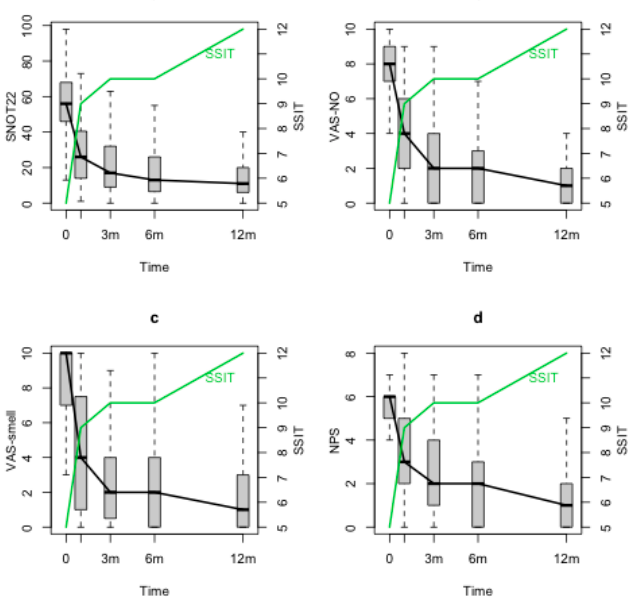
Figure 2. SSIT, SNOT-22, VAS-NO, VAS-smell and NPS changes during the follow-up. SSIT: Sniffin’ Sticks identification test (16 odours), SNOT-22: sinonasal outcome test-22; VAS-NO: visual analogue scale for nasal obstruction; VAS-smell: visual analogue scale for smell; NPS: nasal polyps score; m: